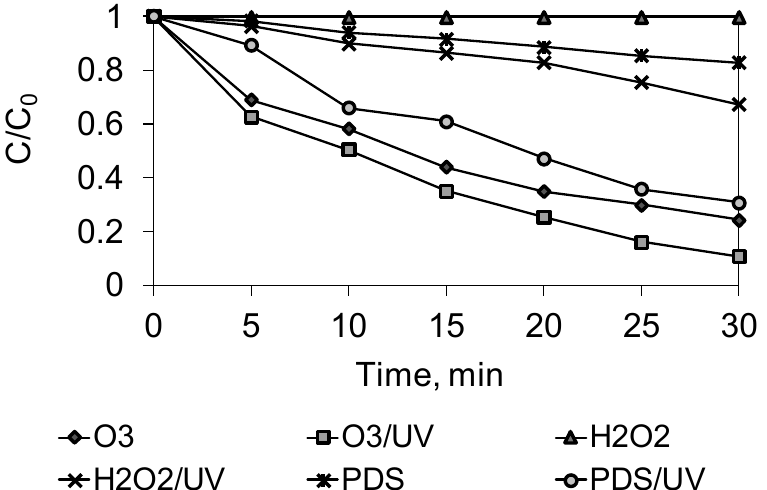
Figure 1. Photodegradation of rhodamine B during different AOP. Conditions: C 0[RhB] = 20.0 mg/L; V = 0.5 L; T = 298.0 K; p = 1013.0 hPa; pH = 6.0; t = 0–30 min.